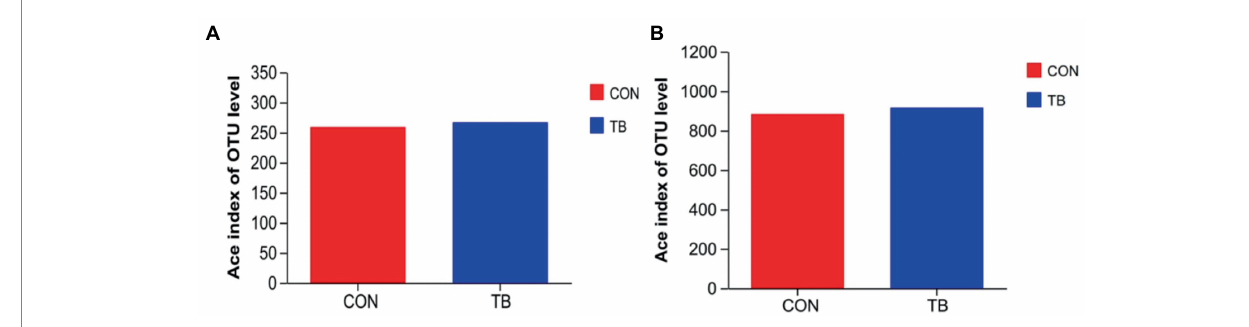
FIGURE 1 Effects of tributyrin on fecal microorganisms of sows (A) and piglets (B) . CON, basal diet; TB, basal diet +500 g/t tributyrin.